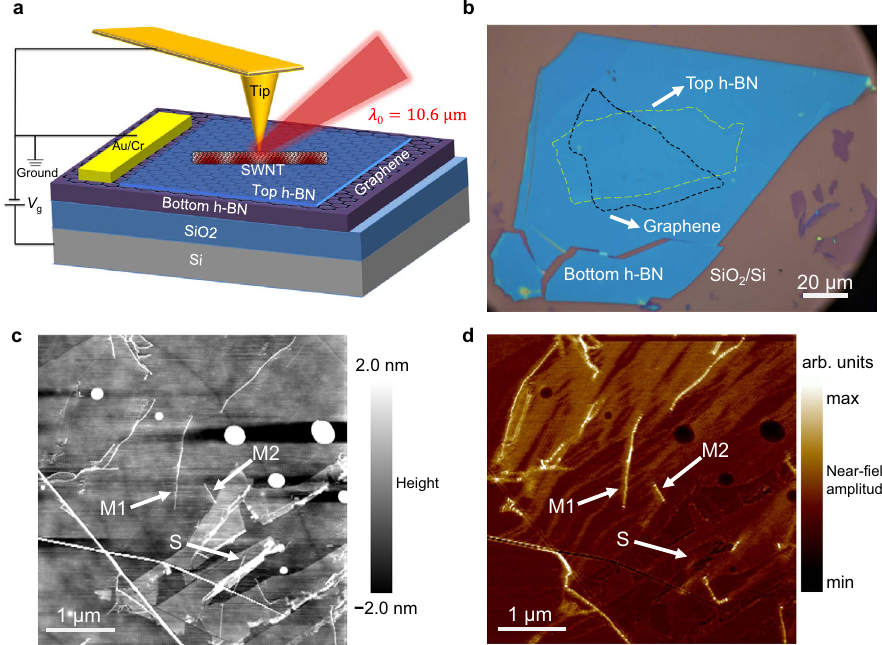
Fig. 1 Infrared nano-imaging of plasmons in a SWNT/h-BN/graphene heterostructure. a Schematic of infrared nano-imaging of plasmons in a SWNT/h- BN/graphene heterostructure. The designed heterostructure is assembled by the standard polymer stamp dry-transfer technique with a top-down layout of SWNT/top h-BN/graphene/bottom h-BN/SiO 2 /Si. Graphene carrier density can be electrostatically tuned by applying a gate voltage V g between the Au/ Cr electrode contacting the exposed graphene and the conductive Si layer. For infrared nano-imaging, a gold-coated AFM tip is illuminated with a focused infrared light beam of wavelength 10.6 μ m. The backscattered light from the tip-sample system is collected to extract the near- fi eld signal. b Optical image of an as-prepared heterostructure. The borders of graphene and top h-BN layers are respectively outlined by black and green dashed lines for clarity. The overlapping region between graphene and top h-BN with SWNTs (optically invisible) on top of it constitutes the SWNT/h-BN/graphene heterostructure. c , d Topography and corresponding near- fi eld image of a representative heterostructure area. M1 and M2 in c are metallic SWNTs with bright contrast in the near- fi eld image due to plasmon excitations whereas S in c is a semiconducting SWNT with a negligible near- fi eld response due to the lack of free electrons.